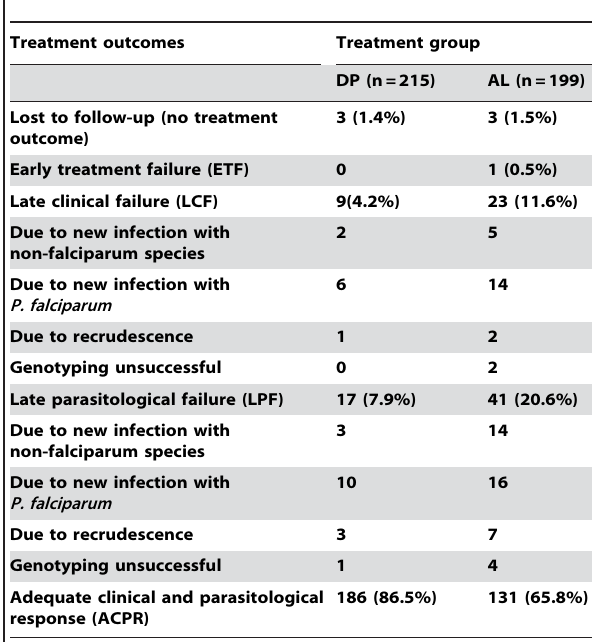
Treatment outcomes Treatment